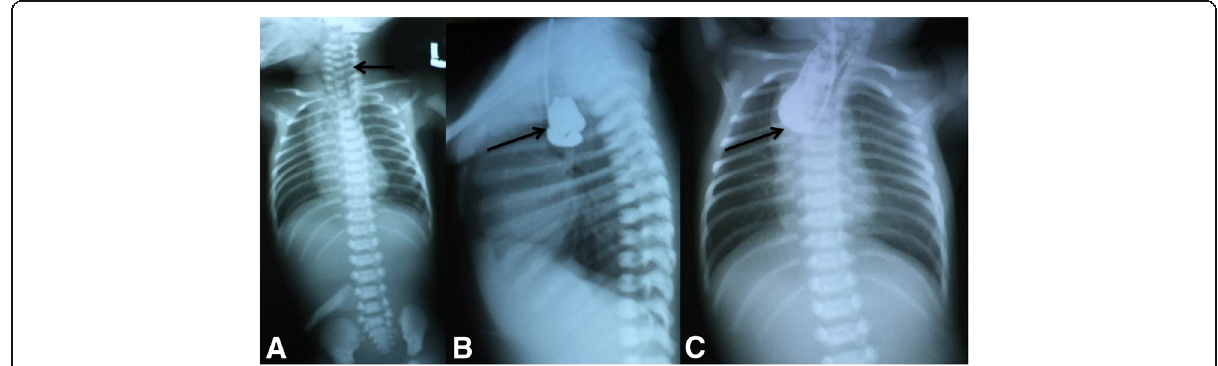
Fig. 4 Esophageal atresia without fistula in a neonate. a Plain X-ray demonstrating faint lucent pouch at the neck and upper chest (arrow) with gasless abdomen. b Lateral esophagogram shows the proximal esophageal pouch (arrow). c AP esophagogram well delineates the proximal esophageal pouch